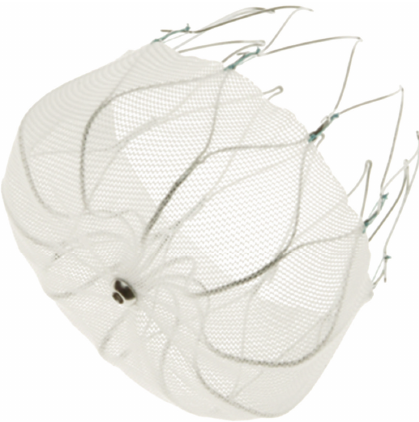
Figure 2: WATCHMAN LAA closure device. (Image courtesy of Atritech, Inc., ©